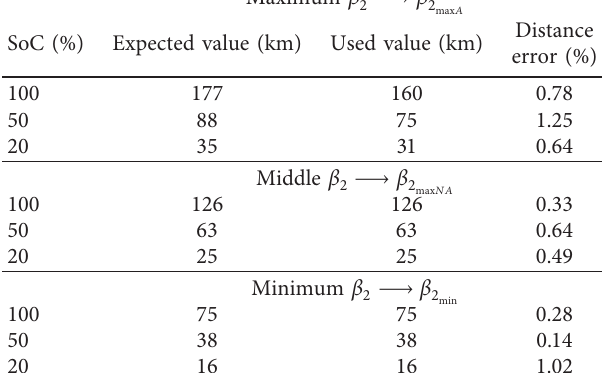
Figure 10: Test diagram. Table 3: Distance error results.